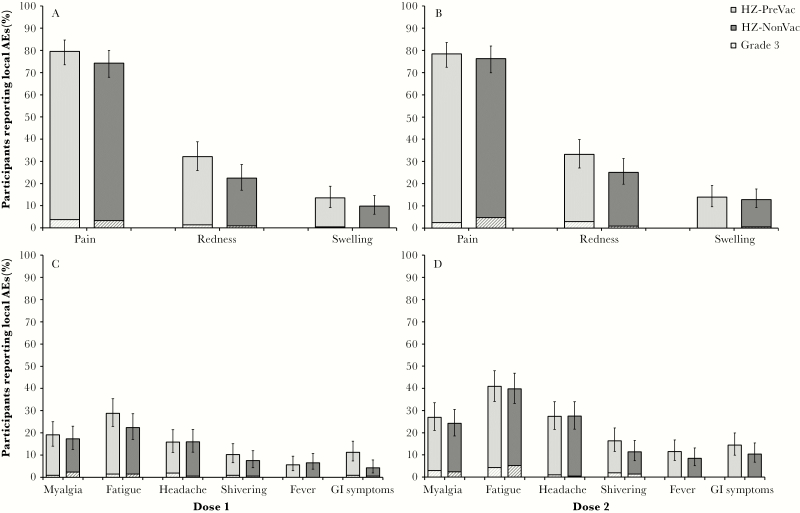
Solicited adverse events (AEs) after vaccination doses (total vaccinated cohort). A, Percentage of participants reporting local solicited AEs after herpes zoster subunit candidate vaccine (HZ/su) dose 1. B, Percentage of participants reporting local solicited AEs after HZ/su dose 2. C, Percentage of participants reporting related systemic solicited AEs after HZ/su dose 1. D, Percentage of participants reporting related systemic solicited AEs after HZ/su dose 2. Light bars indicate participants who received the live attenuated zoster vaccine ≥5 years prior to study start (HZ-PreVac group); dark bars indicate participants who never received the live attenuated zoster vaccine (HZ-NonVac group). Striped sections indicate grade 3 solicited AEs. Error bars indicate 95% confidence intervals.